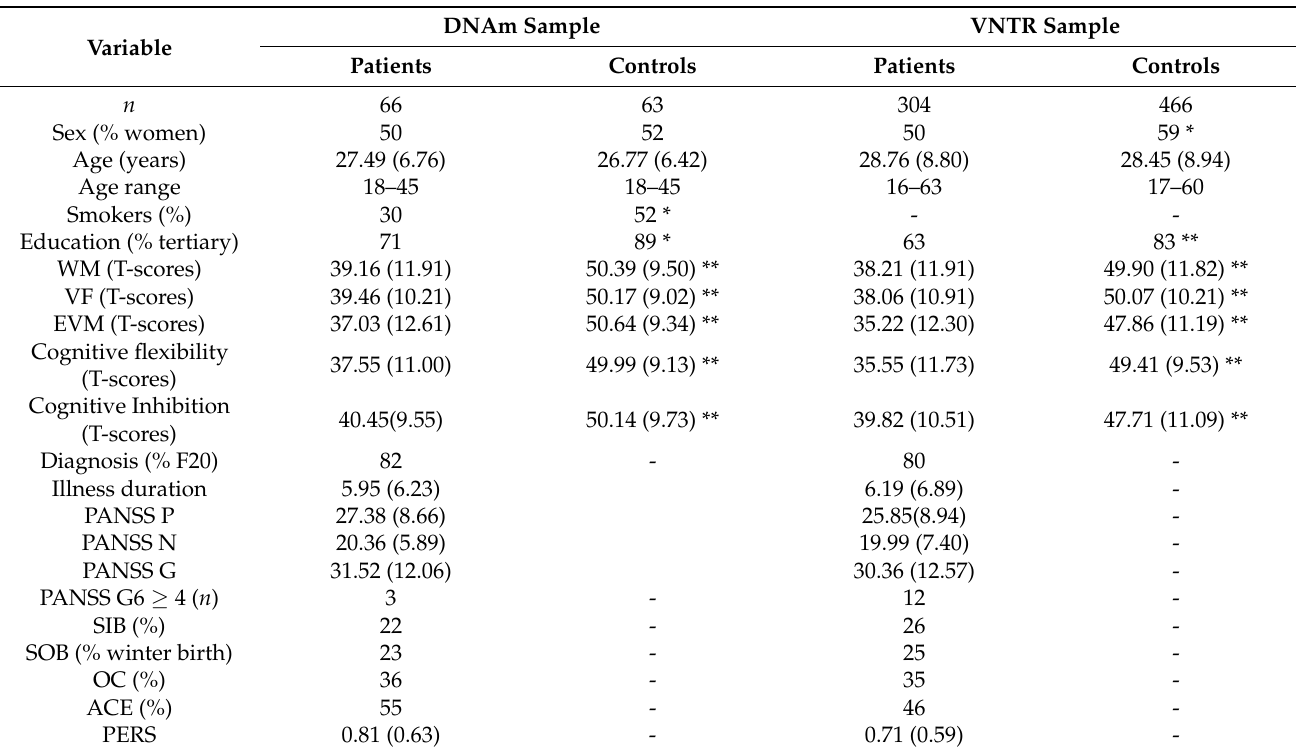
Table 1. Samples’ demographic and clinical